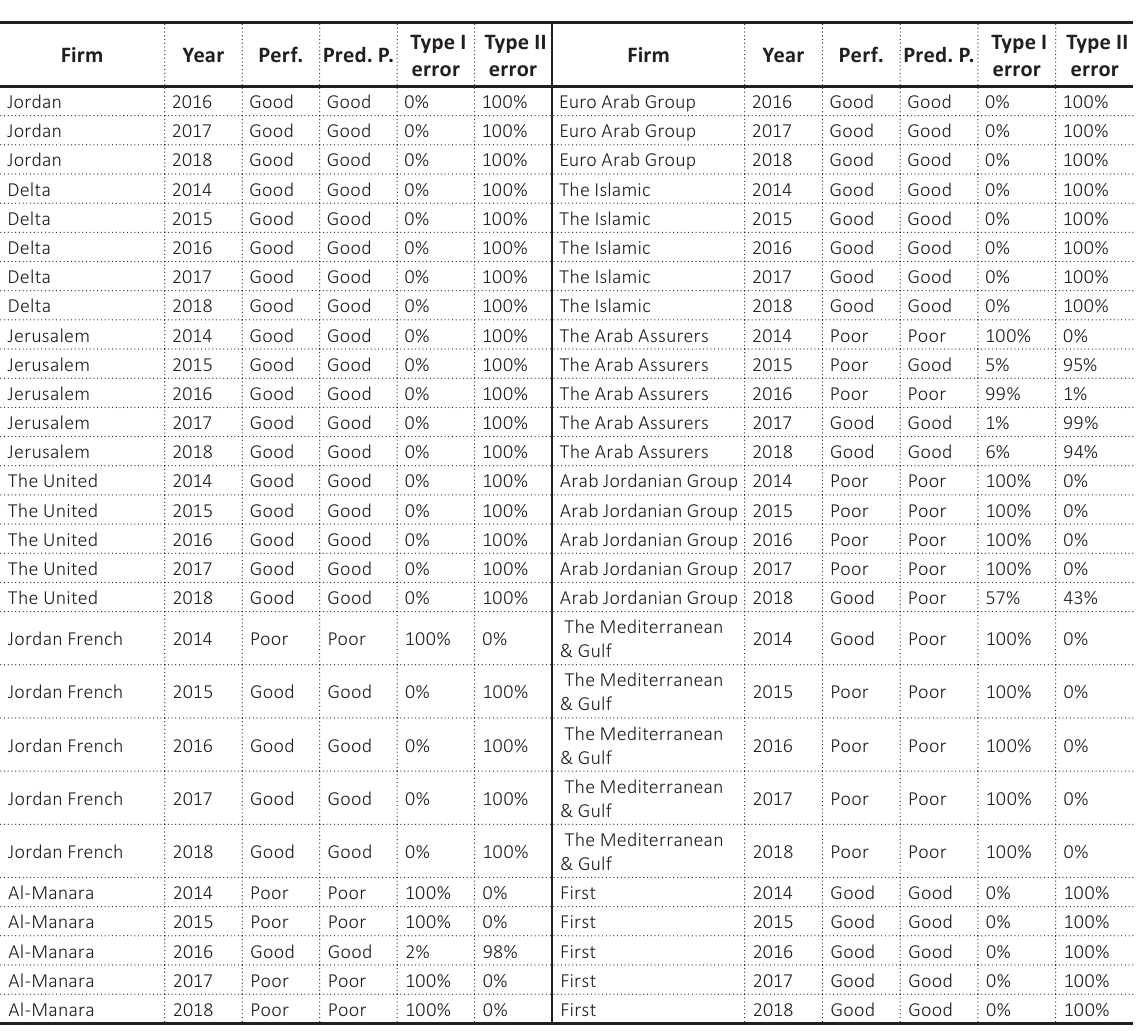
Table 7 (cont.). Comparison of real performance vs. predicted